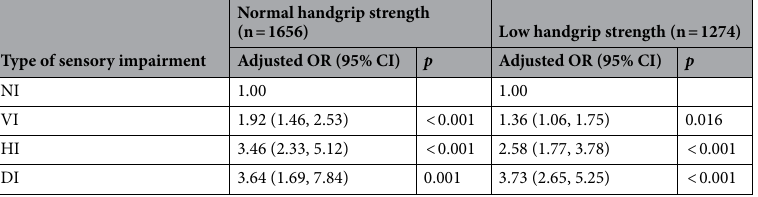
Table 3. Adjusted odds ratios of sensory impairment for the prevalence of cognitive impairment according to handgrip strength status using generalized estimating equations. Adjusted for age, sex, education level, marital status, physical activity, smoking, drinking alcohol, body mass index, number of comorbidity and depressive symptoms. CI confidence interval, DI dual sensory impairment, HI hearing impairment only, NI no sensory impairment, OR odds ratio, VI vision impairment